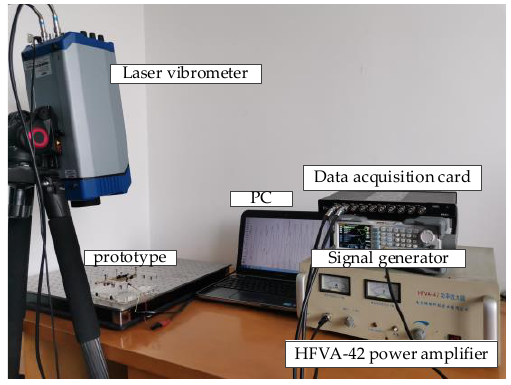
Figure 12. Testing environment of laser vibrometer.